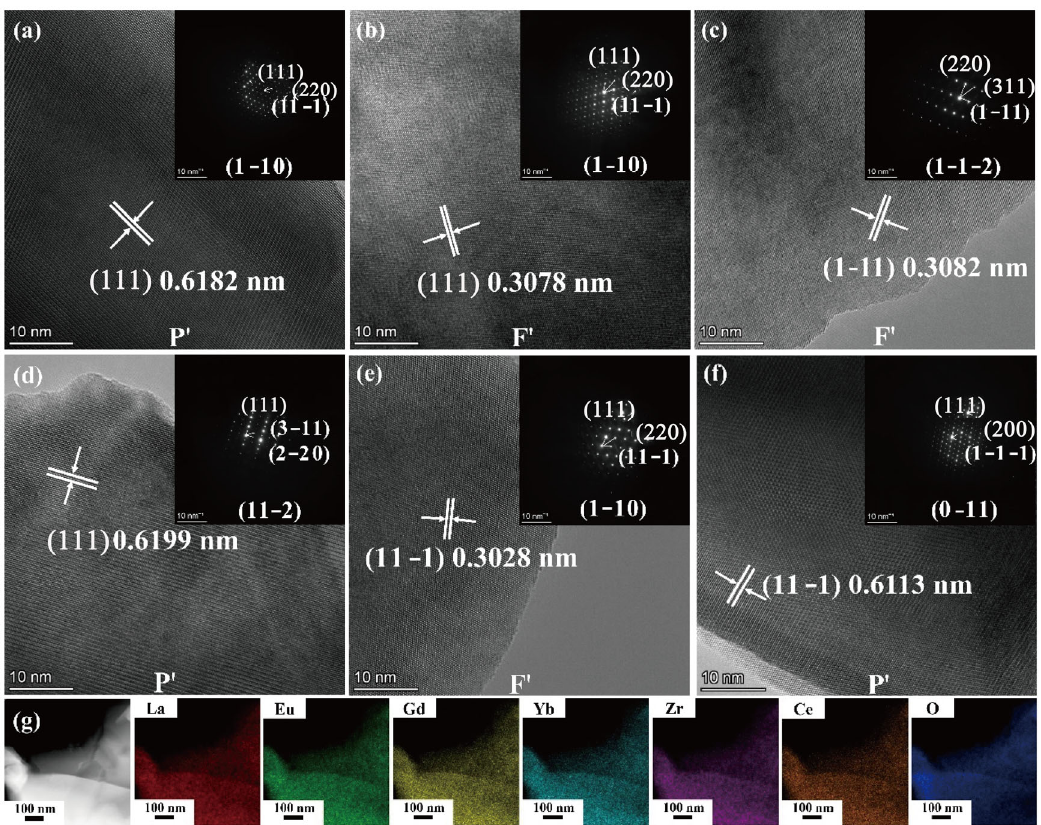
Fig. 3 TEM results of A 2 B 2 O 7 high-entropy ceramics: (a, b) Ce/Hf0, (c) Ce0.05, (d) Ce0.15, (e) Ce0.25, (f) Hf0.25, and (g) scanning transmission electron microscopy–energy dispersive spectroscopy (STEM–EDS) mappings of Ce0.15.